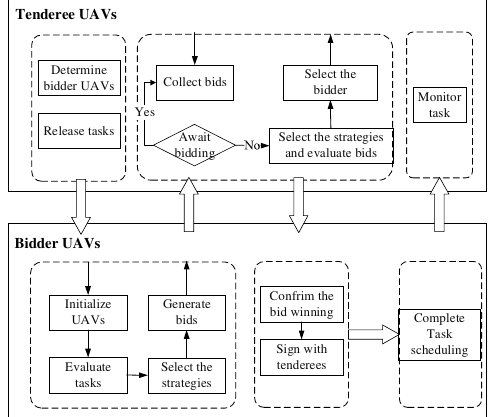
Figure 3. The negotiation process of CNP.